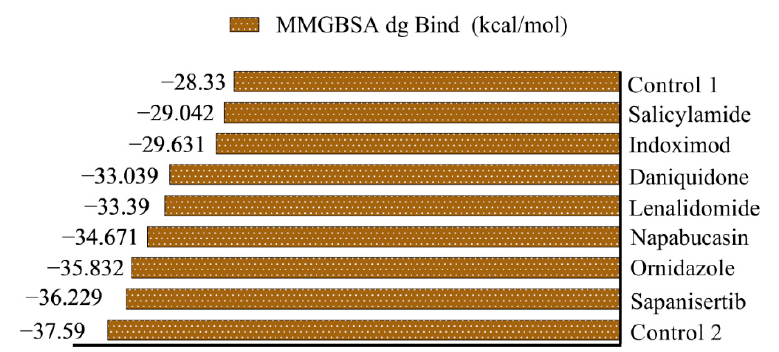
Figure 3. Best drugs from MM/GBSA analysis with MM/GBSA dg Bind score.